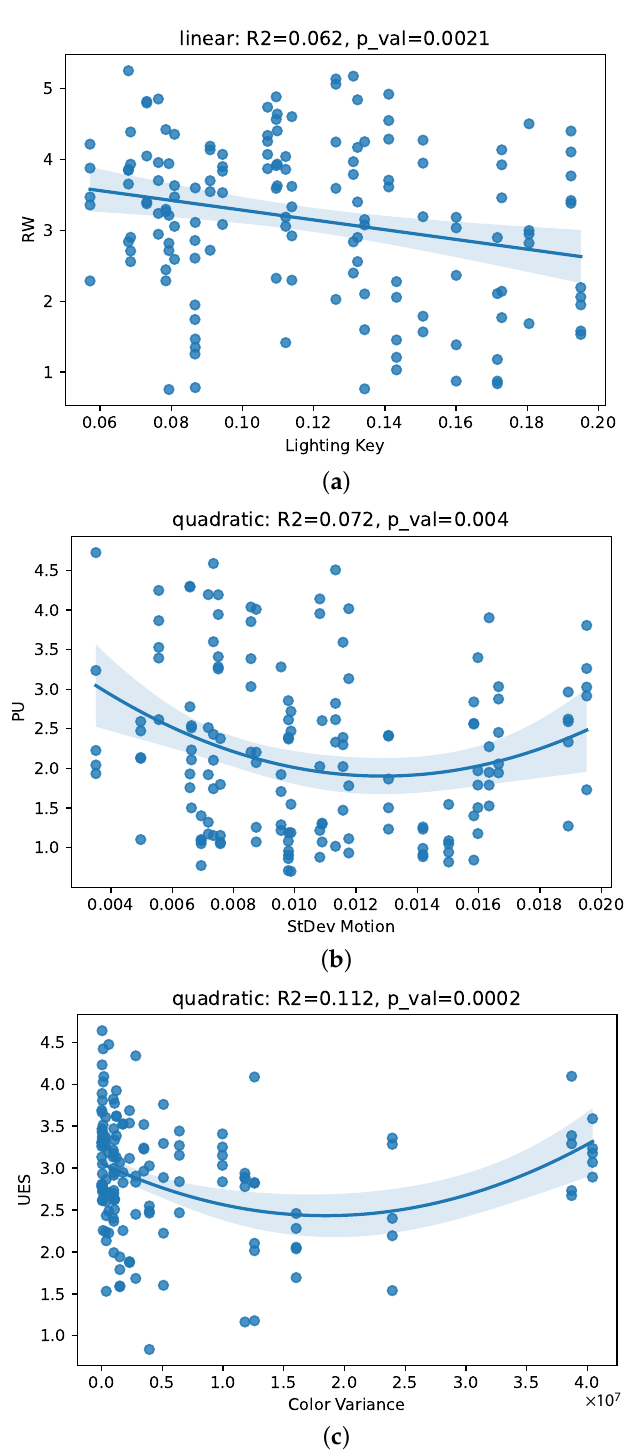
Figure 3. Examples of ( a ) scatter plot and linear model plot of a decreasing linear relation between Lighting Key and Reward (RW); ( b ) scatter plot and a quadratic model plot of relation between Color Variance and overall User Engagement Score (UES), indicating a U-shaped relation; ( c ) scatter and quadratic plot of the relation between Standard Deviation of Motion and Perceived Usability (PU) dimension. Please note that a small jitter was added to improve visualisation of overlapped